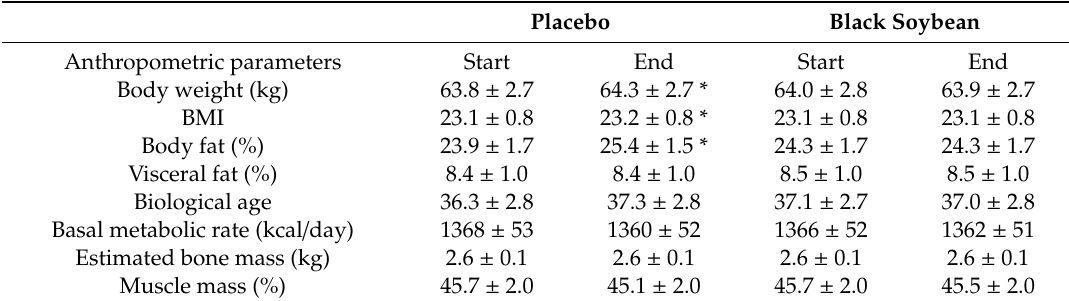
Table 3. Anthropometric parameters of participants during the 4 week trial. Placebo Black